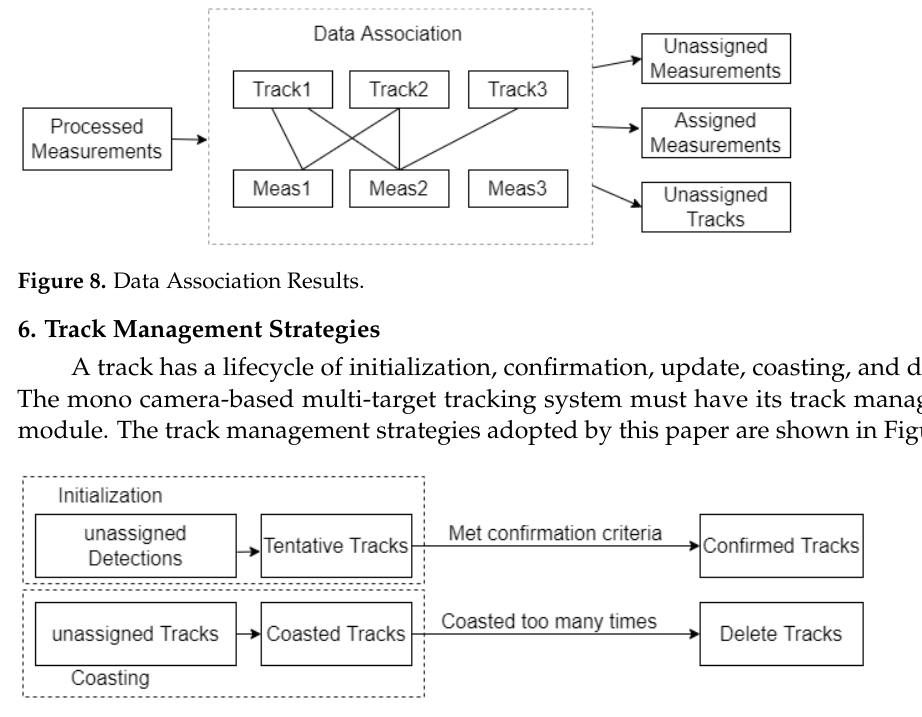
Figure 9. Track Management Strategies.